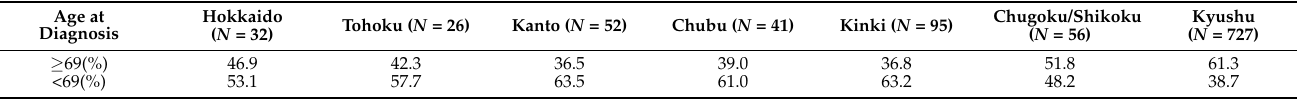
Table 8. Age at diagnosis and area of